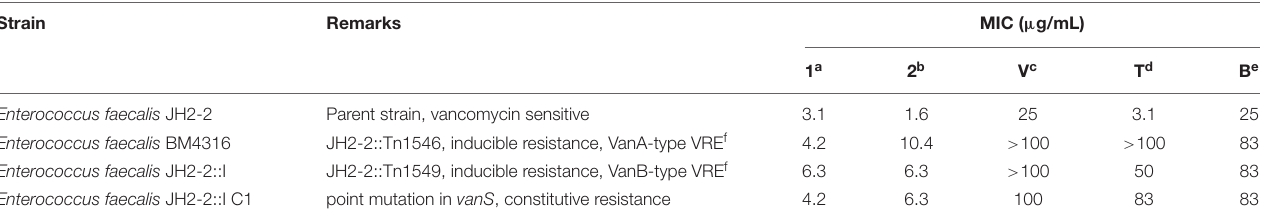
TABLE 2B | Antibacterial activity of lenzimycins A and B ( 1 - 2 ) against additional clinical isolates of Enterococci. Strain